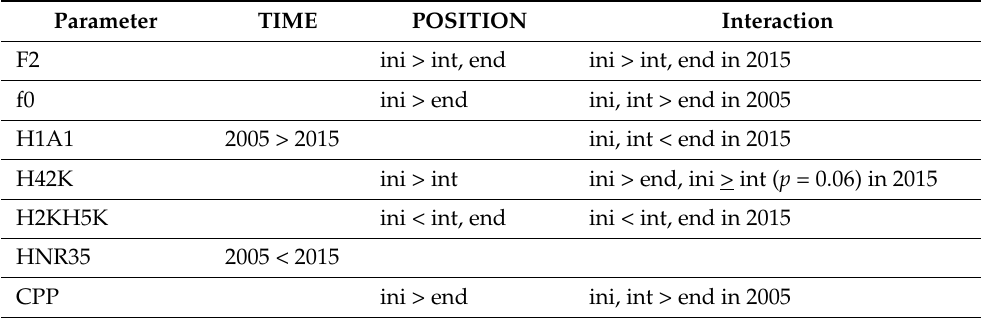
Table 3. Summary of significant effects of TIME (2005 vs. 2015) and POSITION (initial, internal, end), along with